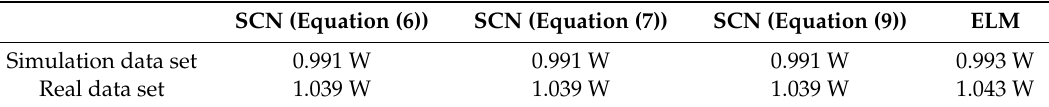
Table 6. Power consumption of FPGA-based prediction models.